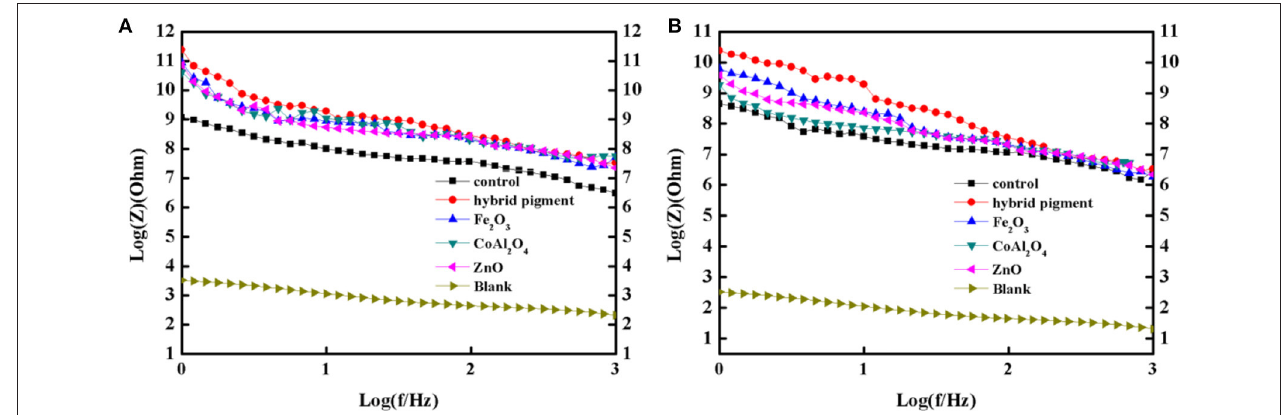
FIGURE 8 | Bode plots of the coatings containing CoAl 2 O 4 /Kaol hybrid pigment, ZnO, Fe 2 O 3 , CoAl 2 O 4 , the control without pigment and steel before (A) and after (B) being immersed in the 3.5 wt% NaCl solution for 60 days.